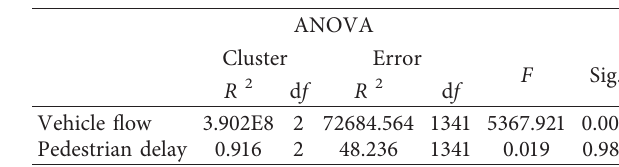
Table 6: Clustering variance of vehicle flow and pedestrian delay.